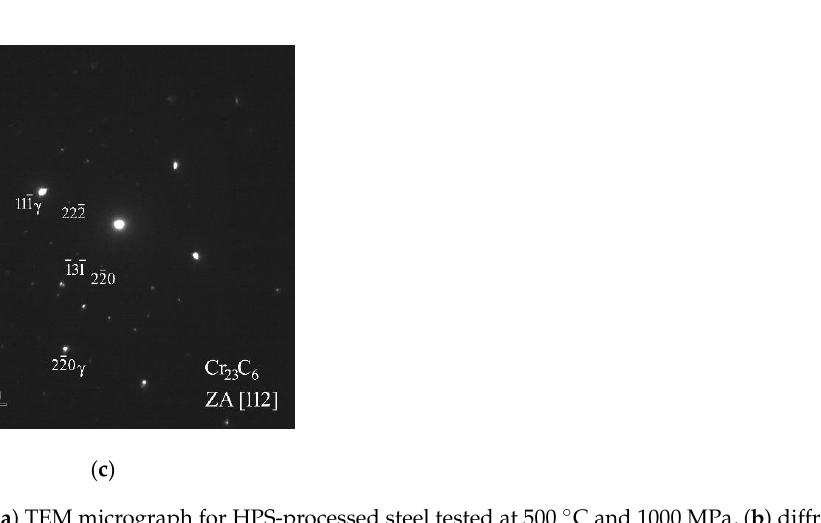
Figure 7. (a) TEM micrograph for HPS-processed steel tested at 500 °C and 1000 MPa, ( b ) diffraction pattern of austenitic matrix and fine coherent Cu precipitates, ( c ) diffraction pattern of Cr 23 C 6 carbide. The HPS-processed microstructure after creep testing at 600 ◦ C and 400 MPa is shown in Figure 8a. One can see that creep testing at 600 ◦ C led not only to the grain coarsening but also to the formation of σ -phase along the grain boundary and at Cr 23 C 6 carbide interface and to the coarsening of Cu precipitates. Figure 8b–d shows the chemical composition (point analysis) of the Cu precipitate, Cr 23 C 6 carbide, and σ -phase. The chemical composi- tion of the fine Cu precipitate is significantly influenced by the chemical composition of the matrix.